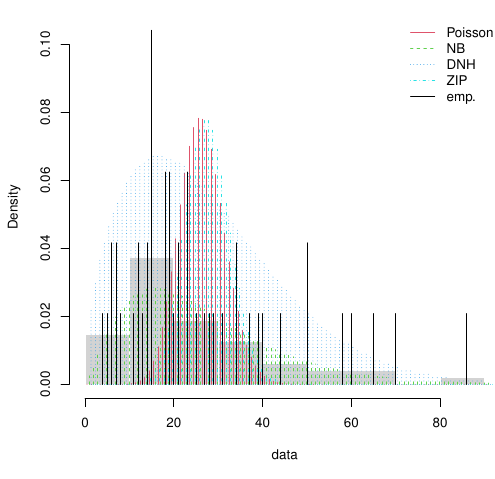
Figure 6 – Density plot for the data on examination marks in